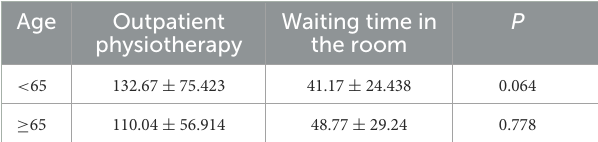
TABLE 6 Correlation of “age” with the number of sessions of outpatient physiotherapy and the number of waiting days (Spearman’s correlation